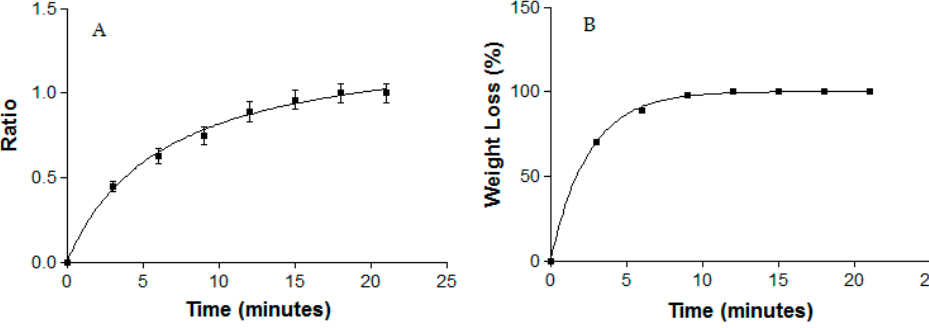
Figure 2. ( A ) Swelling ratio and ( B ) percentage of weight loss in the degradation of MA gel.